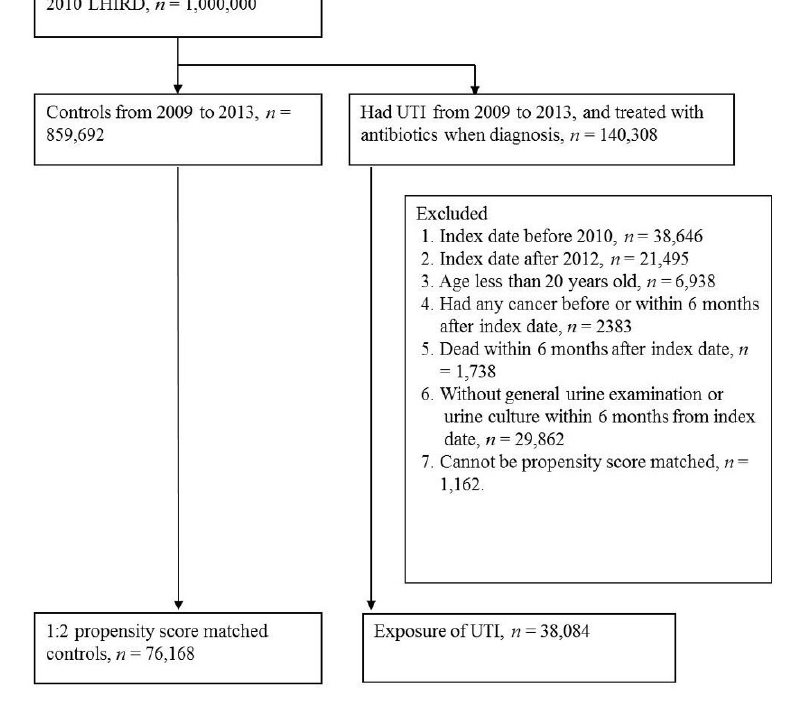
Figure 1. Flow chart for patient selection. Table 1. Baseline characteristics of the study population.